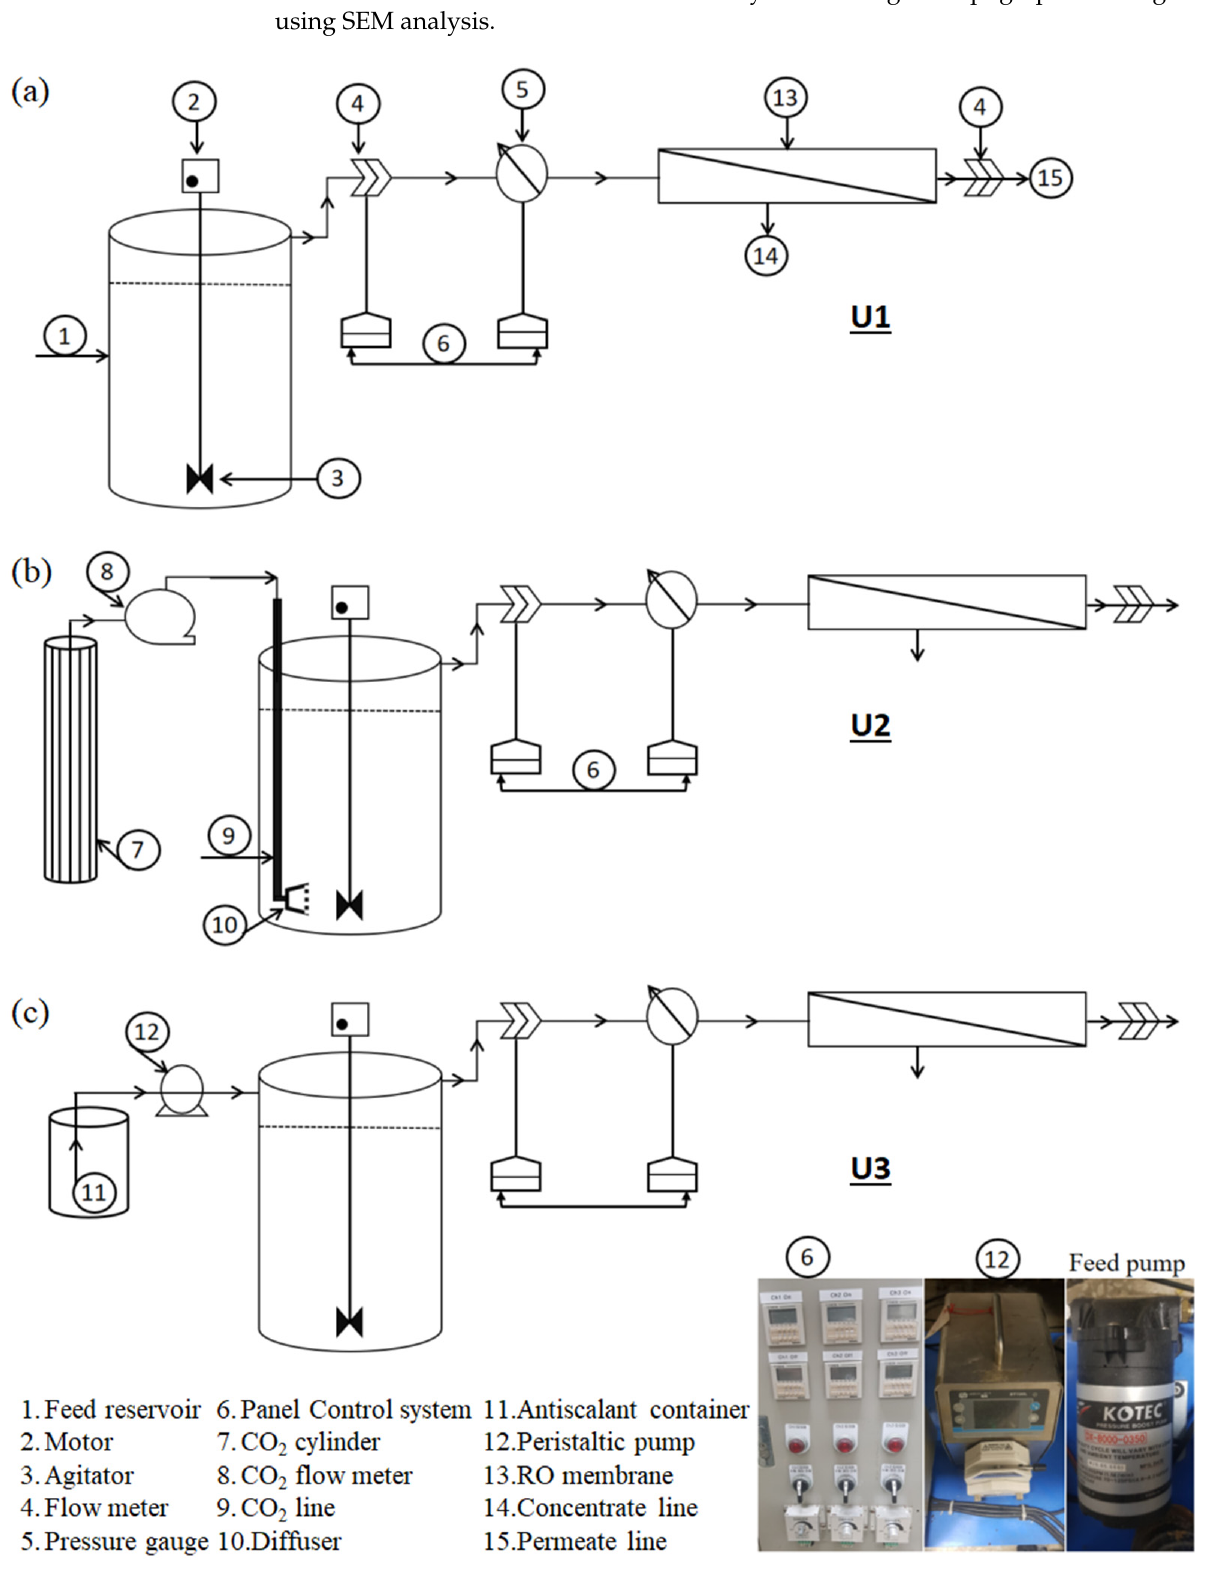
Figure 1. Schematic illustration of ( a ) U1, ( b ) U2, and ( c ) U3.